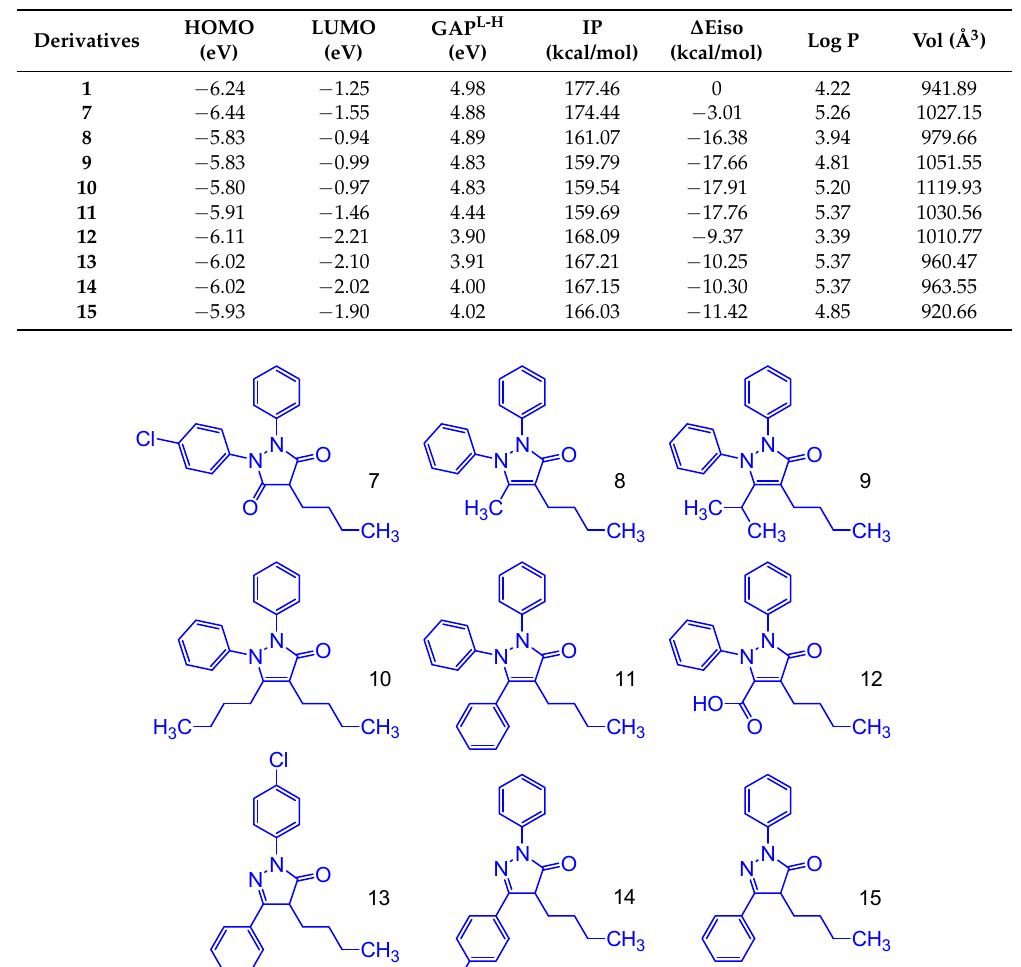
Table 2. Theoretical properties of proposed phenylbutazone derivatives.